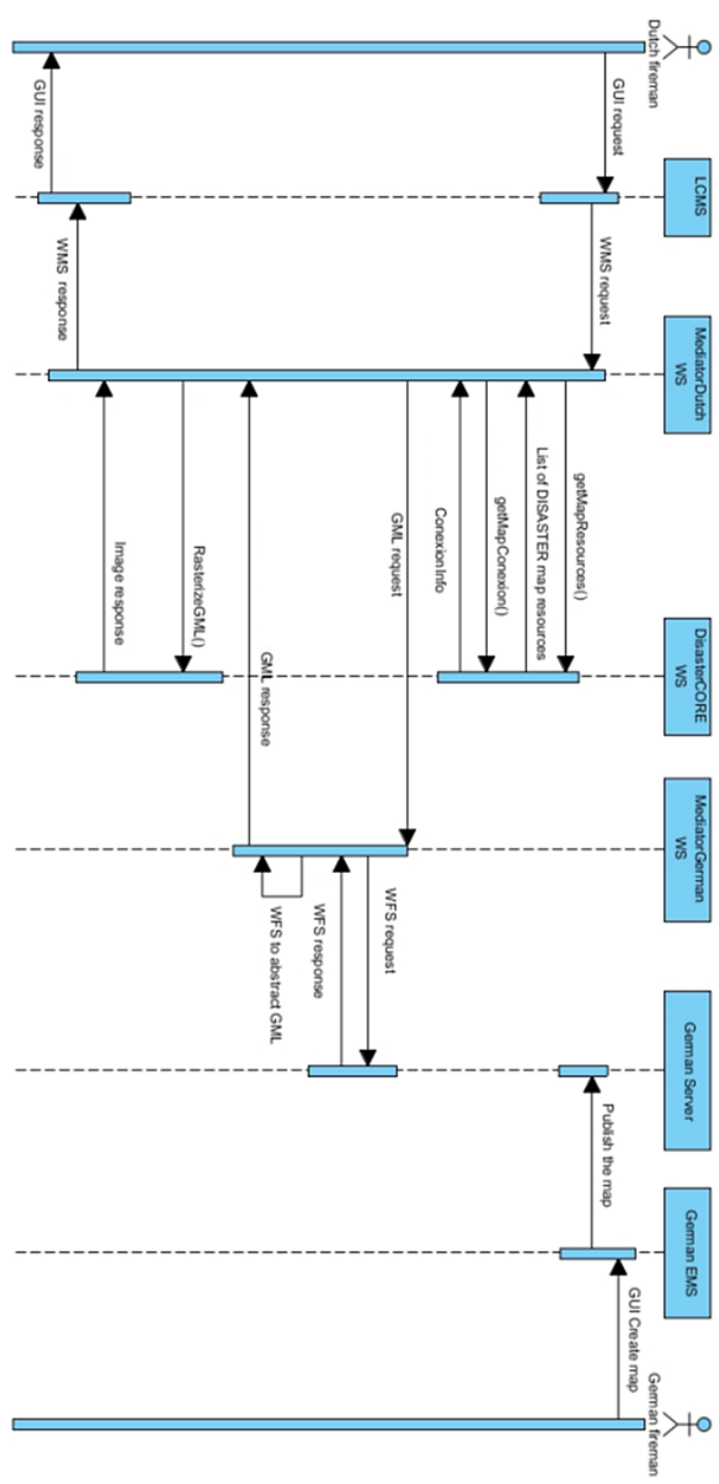
Figure 7. Sequence diagram for the border fire